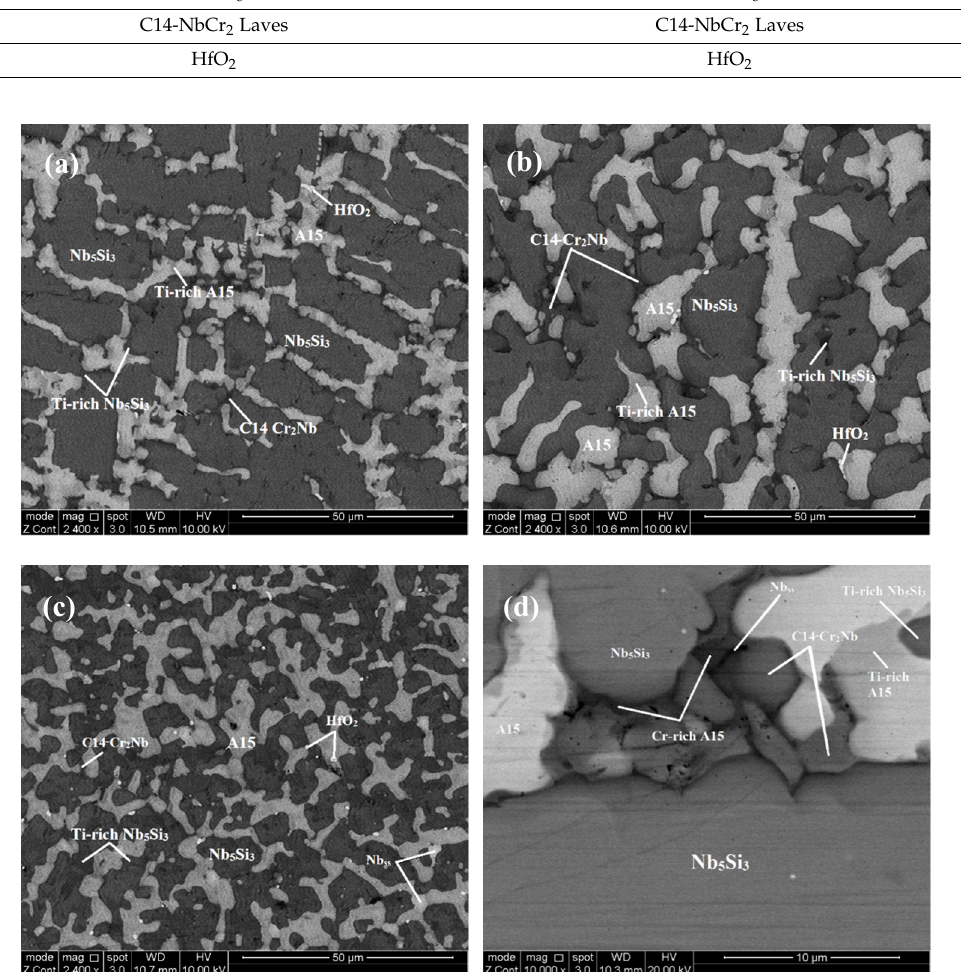
Figure 3. BSE images of the microstructure of the alloy JZ3-AC in the ( a ) top, ( b ) bulk, ( c ) bottom. Details of bulk microstructure are shown in ( d ). Table 2. Average chemical compositions (at.%) and summary of phases in as cast and heat treated alloys JZ3 and JZ3+.